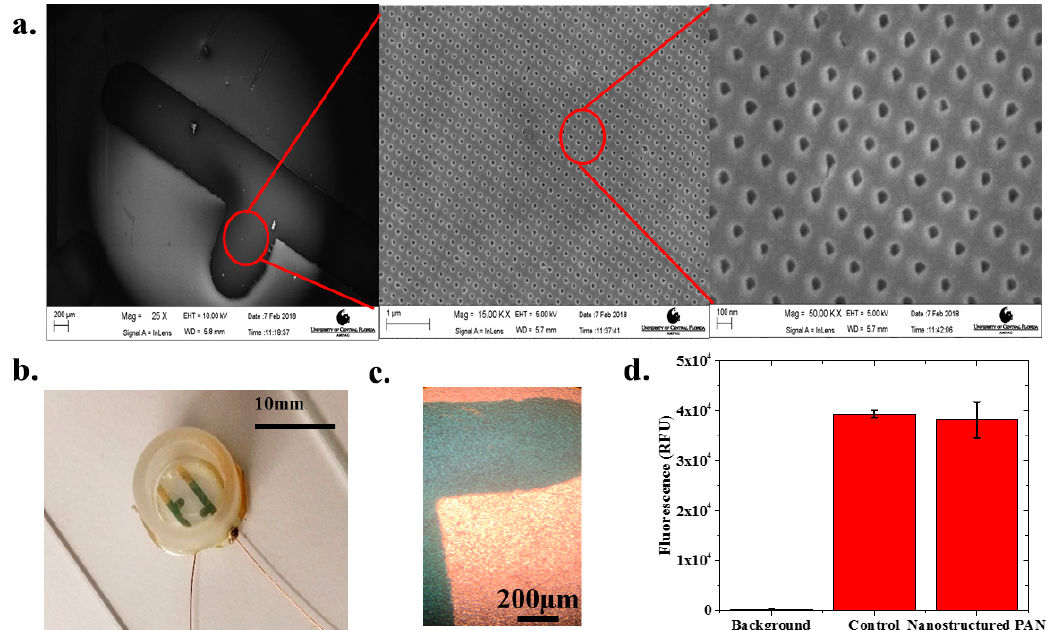
Figure 2. ( a ) SEM image of electrodes deposited on top of the nanostructured PAN layer with zoomed-in SEM images of the printed 50 nm PAN nanohole structures. Scales from left to right are 250 µ m, 1 µ m, and 180 nm, respectively; ( b ) Completed nIDE device with culture well and wires attached; ( c ) Human iPSC Cardiomyocytes cultured on 1 mm pitch nIDE at DIV01. The cardiomyocytes completely cover the surface of the IDE; ( d ) Biocompatibility assay results: the nanostructured PAN substrate shows similar (97.01% ± 2.15%) biocompatibility (N = 6) to control samples comprised of just cells in a six-well plate.